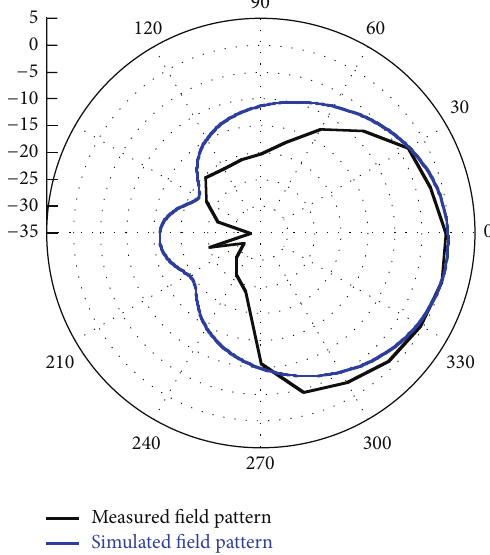
Figure 19: Simulation and measured field pattern comparison.